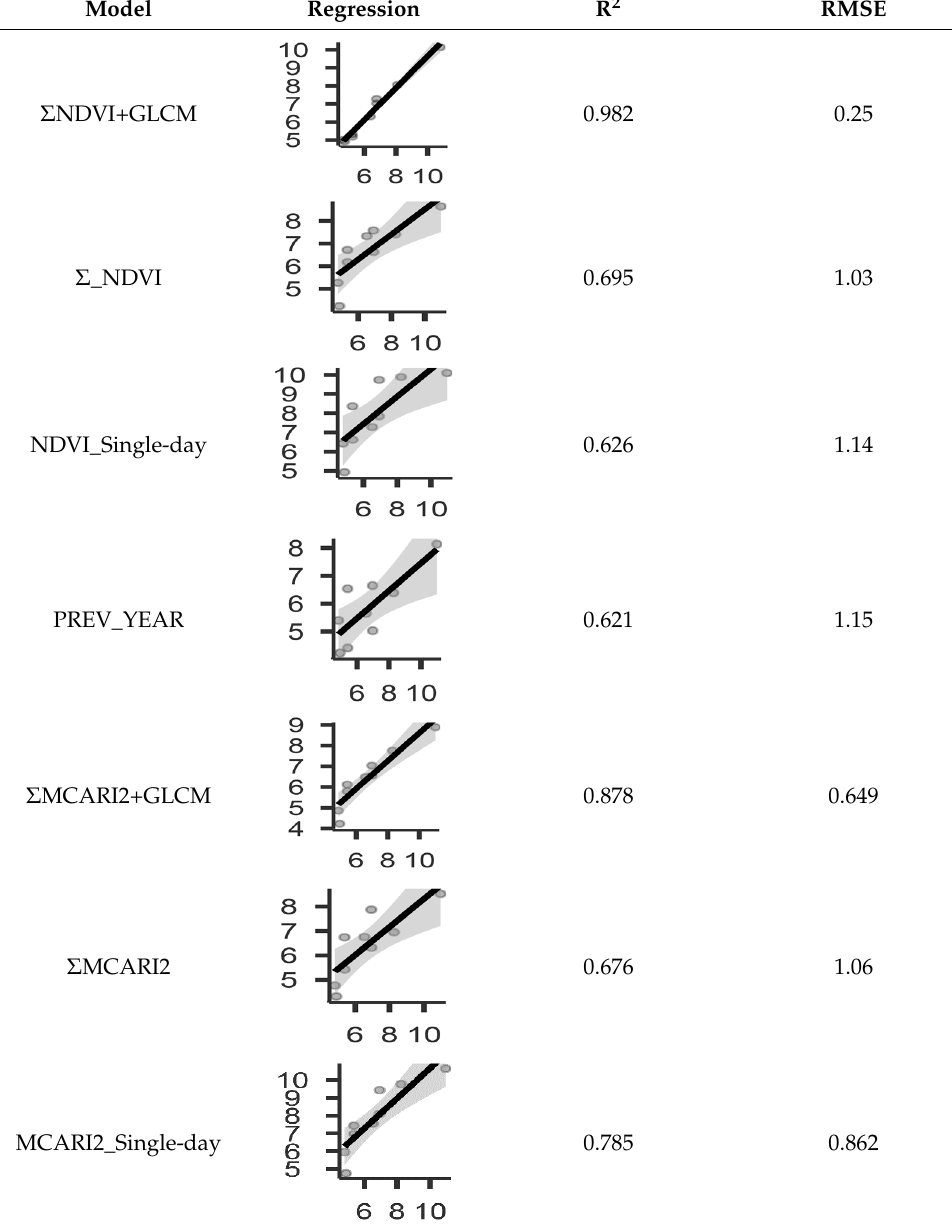
Table 5. Relationship between the averages calculated in the clusters obtained from the models compared with the cluster averages obtained from the yield values.